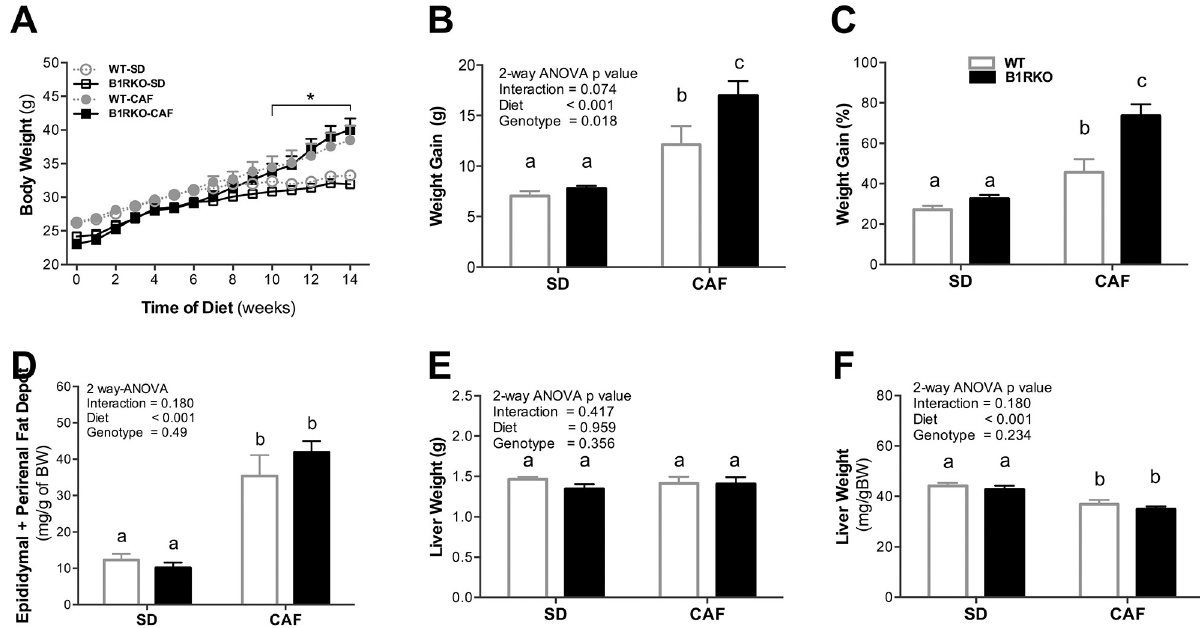
Fig 1. Changes in body weight, epididymal and perirenal fat, and liver weight according to diet and genotype. A) Weekly body weight over the 14-week diet protocol. B and C ) Weight gain. D) Relative epididymal and perirenal fat pad weight is higher in CAF animals compared to SD animals. E) Absolute liver weight. F) Relative liver weight. P-value by two-way ANOVA followed by Bonferroni post-hoc test. Different letters indicate differences in post-hoc test. Data presented as mean ± SEM. WT, wild type; B1RKO, B1R knockout mice; SD, standard diet; CAF, cafeteria diet, WT-SD (n = 7), B1RKO-SD (n = 8), WT-CAF (n = 7), and B1RKO-CAF (n =